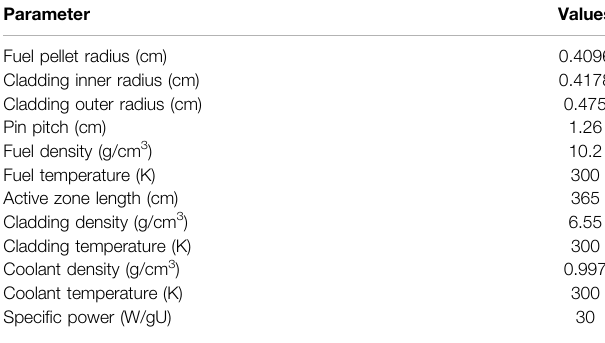
TABLE 2 | Physical properties for the fi rst veri fi cation